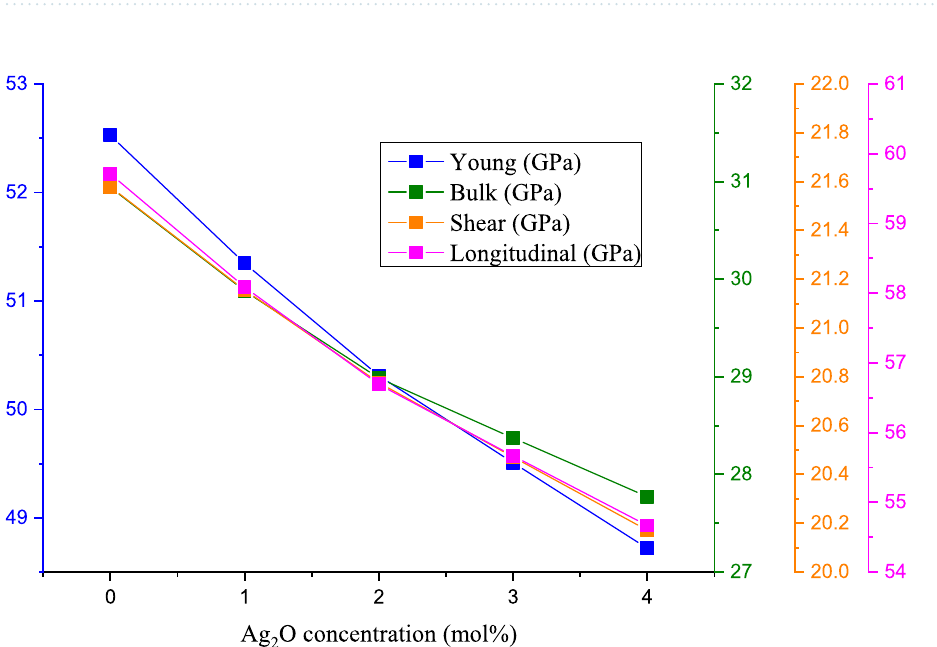
Figure 9. The elastic moduli (Young, shear, bulk, and longitudinal) variations at Ag 2 O doping